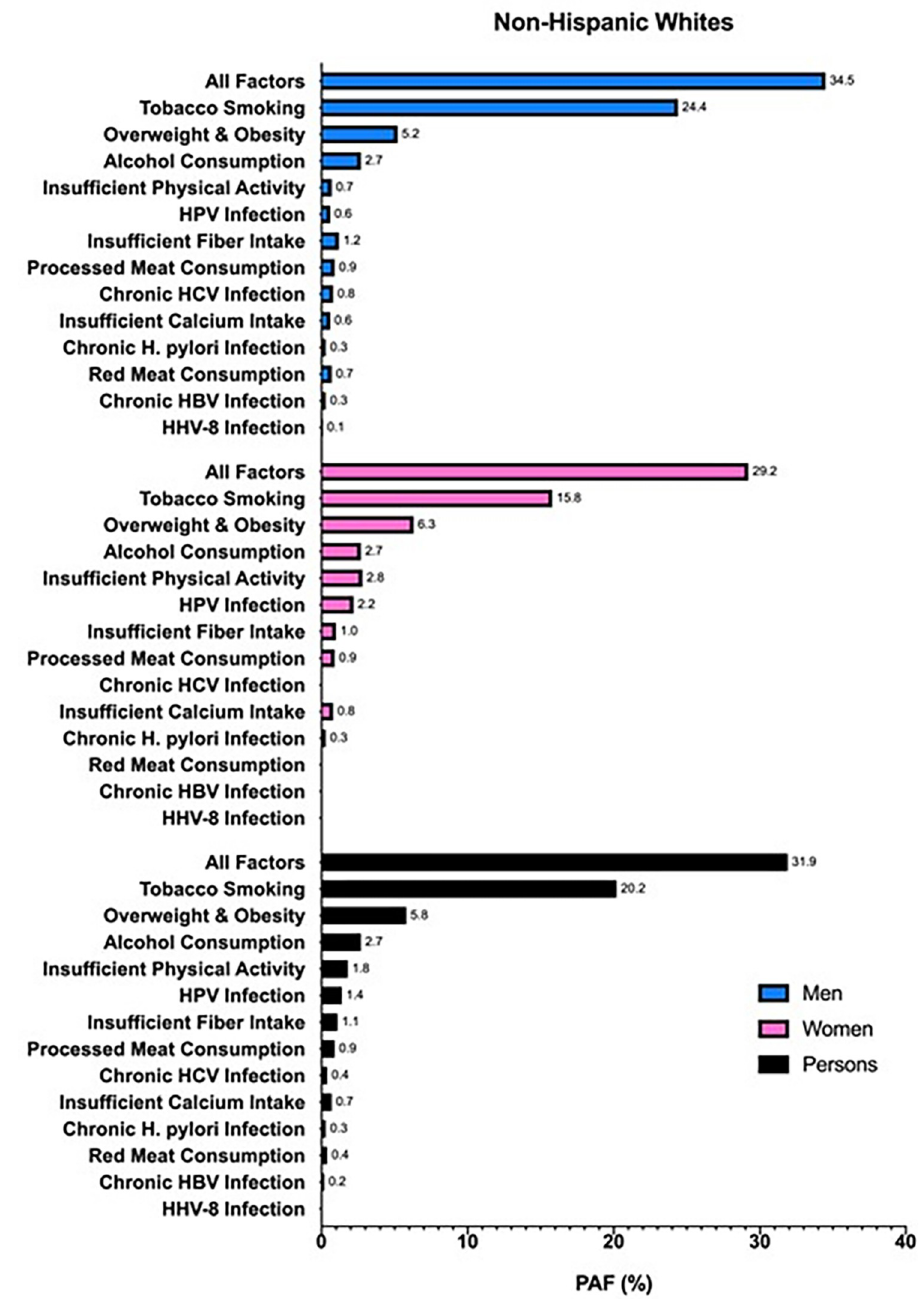
Fig 2. PAFs (%) of incident cancers attributable to modifiable risk factors in Texas in 2015 for non-Hispanic White men (blue), women (pink), and persons (black) aged � 25 years. overall PAF across the major racial/ethnic subgroups, followed by overweight and obesity; however, the third highest overall PAF in non-Hispanic Black men was for HCV infection, as opposed to excess alcohol consumption in non-Hispanic White and Hispanic men. In women, tobacco smoking had the highest overall PAF in non-Hispanic Whites and non-Hispanic Blacks, followed by overweight and obesity and insufficient physical activity; yet, in Hispanic